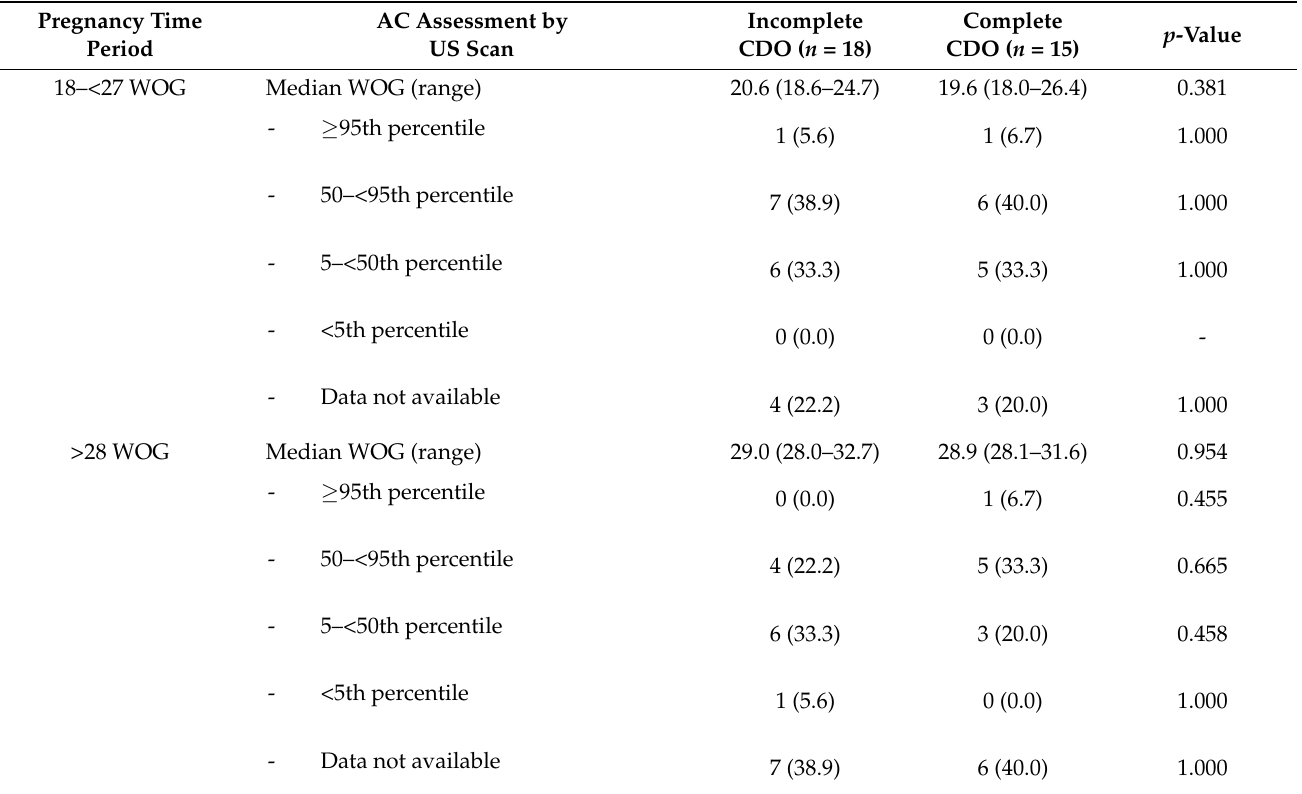
Table 3. Abdominal circumference assessment in fetuses with complete or incomplete